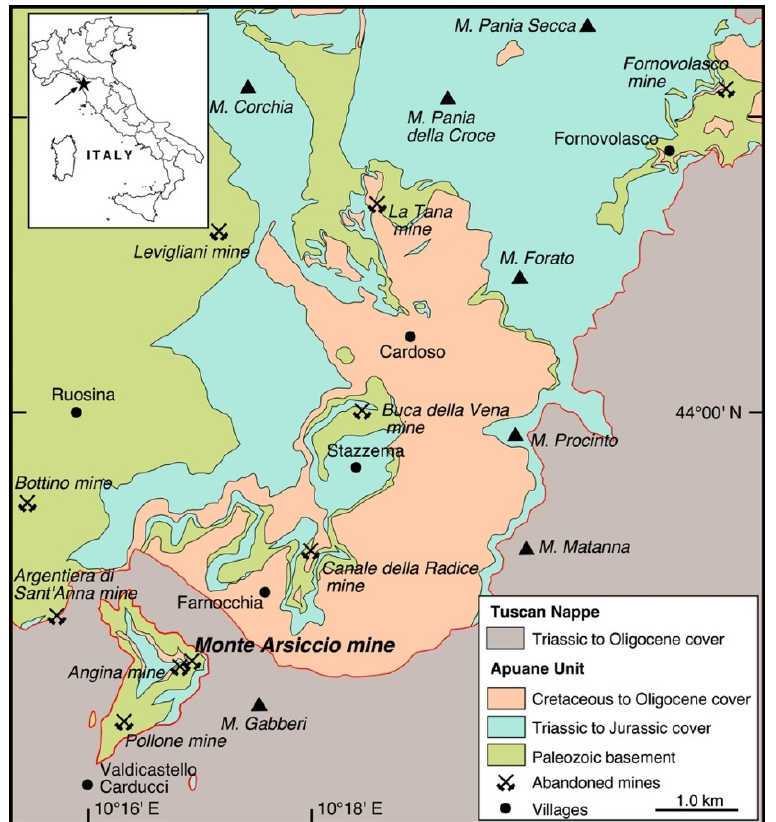
Figure 1. Simplified geological map of the Southern Apuan Alps, showing the location of the Monte Arsiccio mine and of the other abandoned mines of the area. The Monte Arsiccio mine exploited the economically most important pyrite ± baryte ± iron oxide deposit in the Apuan Alps. The orebodies are hosted within a Paleozoic metavolcanic–metasedimentary sequence, locally tourmalinized, close to the contact